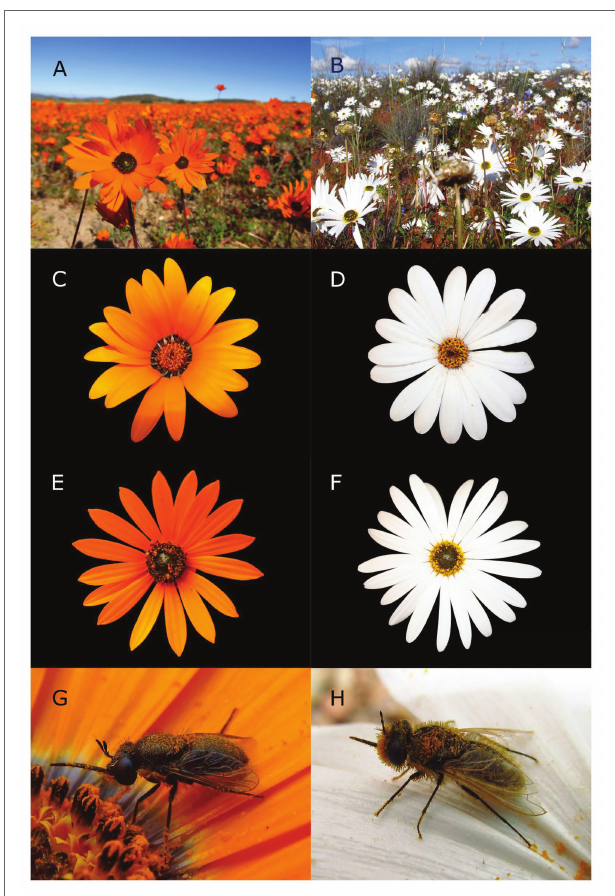
FIGURE 1 | The annual daisy species and their pollinators that characterize orange (A) and white (B) dominated communities in Namaqualand. Dimorphotheca sinuata (C) and Dimorphotheca pluvialis (D) are widespread and dominant in the Kamiesberg and Sandveld bioregions, respectively. Ursinia cakilefolia (E) and Ursinia speciosa (F) are more localized but dominate communities they occur in. The bombyliid flies, Megapalpus capensis (G) and Corsomyza nigripes (H) are dominant pollinators in the orange and white communities, respectively. The inflorescence diameter of the two Dimorphotheca species is on average 35 mm, and the diameter of the two Ursinia species is on average 31 mm. Both fly species show variation in size but are always smaller than 10 mm. Photos: